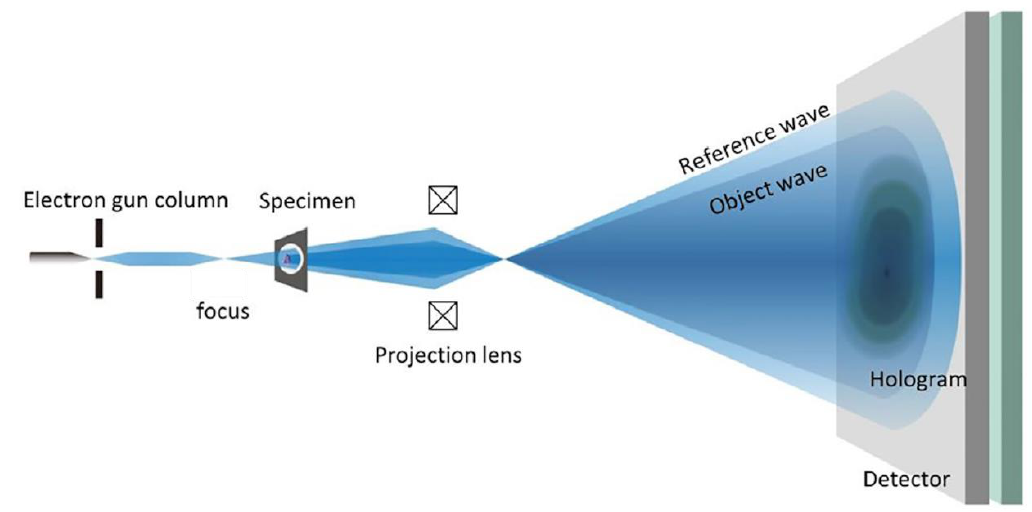
Figure 2. Scheme of the in-line hologram as firstly proposed by Dennis Gabor.